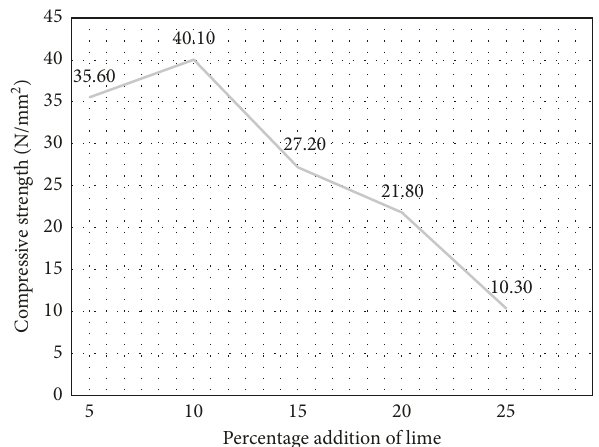
Figure 1: Percentage addition of lime powder in GPC oven cured at 90 ° C.